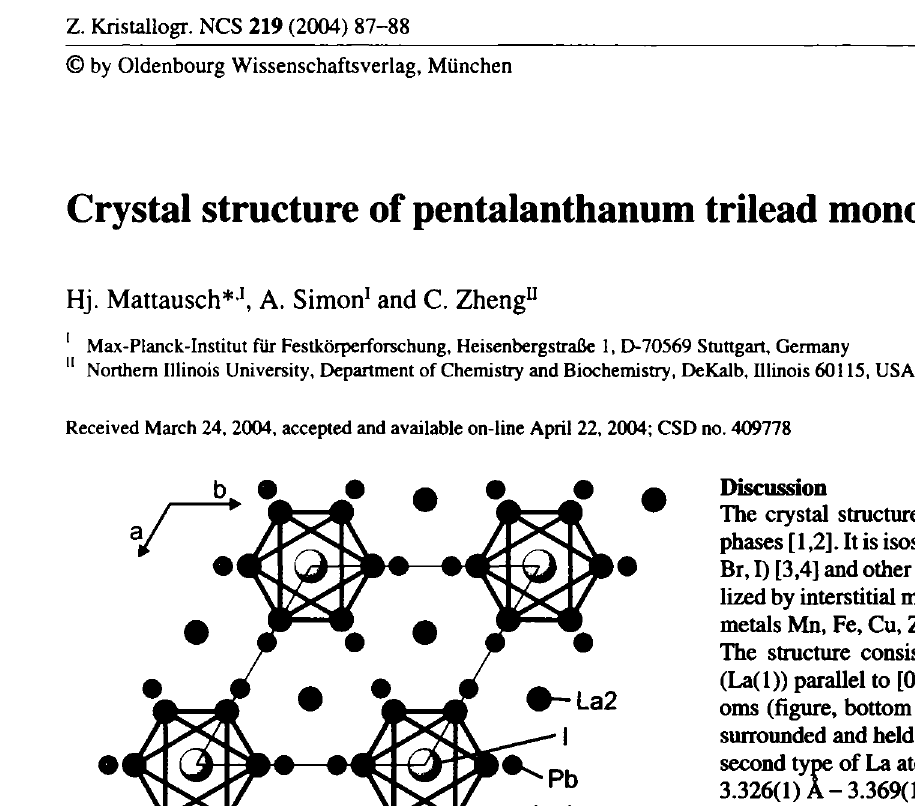
Table 1. Data collection and handling.